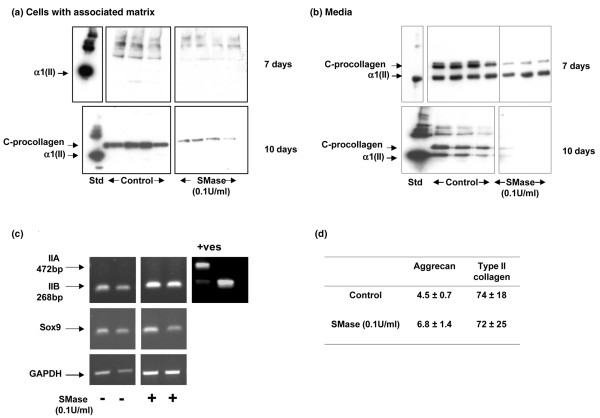
A differentiated chondrocyte phenotype is maintained but sphingomyelinase treatment reduces type II collagen expression. Bovine articular chondrocytes were cultured as monolayers for 7–10 days in ITS supplemented media in the presence or absence of SMase (0.1 U/ml). Where cultures were extended to 10 days, media and treatments were refreshed at day 7. (a) Equivalent numbers of cells and their associated matrix and (b) media were resolved on 7.5% (weight/vol) SDS-PAGE gels. Samples were analyzed for type II collagen by Western blotting using our monoclonal antibody (AVT6E3). In addition, cells cultured in the presence (+) or absence (-) of SMase (0.1 U/ml) for this period were placed into TRIZOL® (1 × 106 cells/ml) and total RNA extracted, in accordance with the manufacturer's instructions. (c) cDNA was generated and PCR performed using primers to type IIA and IIB procollagen and Sox9. cDNA integrity was confirmed using primers to GAPDH. (d) The relative expression level, normalized to GAPDH, of aggrecan and type II collagen mRNAs was determined by quantitative PCR. Data are presented as mean ± standard error. α1(II), α1 chain type II collagen. bp, base pairs; GAPDH, glyceraldehyde-3-phosphate dehydrogenase; ITS, insulin-transferrin-sodium selenite; RT-PCR, reverse transcription polymerase chain reaction; SMse, sphingomyelinase.